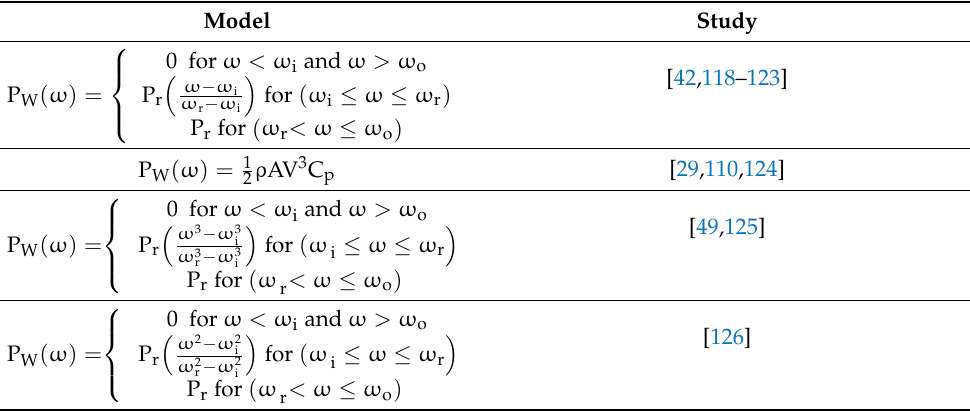
Table 4. Models for Determining Wind Energy Output.